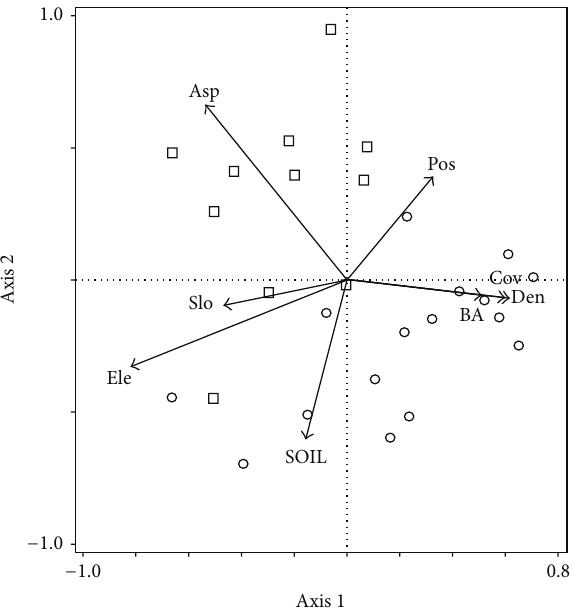
Figure 1: The CCA ordination of 27 plots and environmental vari- ables. Arrows indicate the environmental variables (Ele, elevation; Asp, aspect; Slo, slope; Pos, slope position; BA, basal area; Cov, canopy cover; Den, tree density). Plots dominated by P . crassifolia and S . przewalskii are represented by circles ( 𝑛 = 16 ) and squares ( 𝑛 = 11 ),